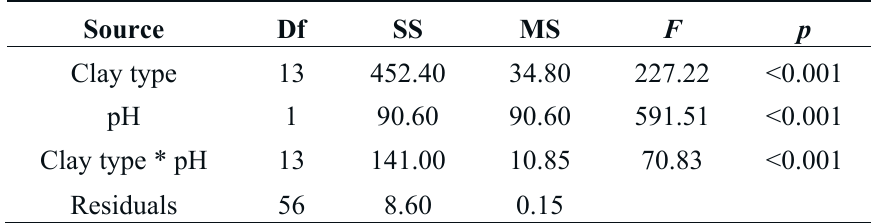
Table 2. Two-way analysis of variance (ANOVA) conducted on the main effects of clay type, pH and their interaction on gill cell viability. Degrees of freedom (Df), sum of squares (SS) and mean square values (MS) are